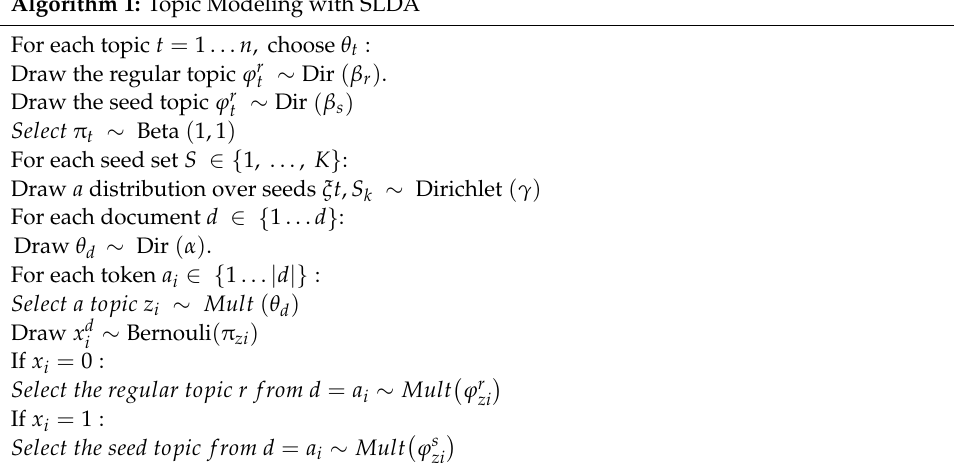
Algorithm 1: Topic Modeling with SLDA Table 3. SLDA topic generation process.